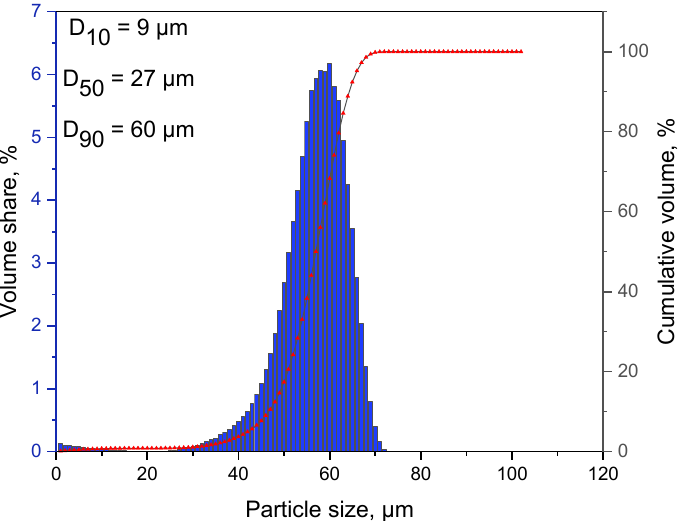
Figure 10. Granulometry chart of the Mg–Zn–Ca–Au powder alloy after 13 h of milling.